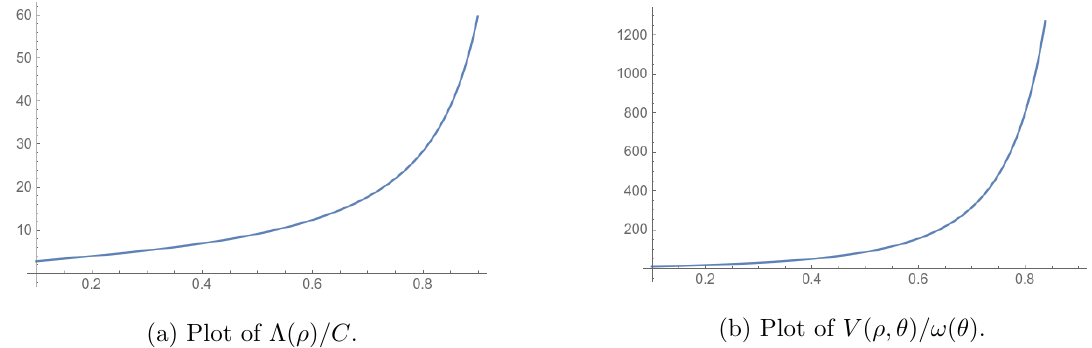
(a) Plot of (cid:3)( (cid:26) ) =C . Figure 12. Plot of the radial pro(cid:12)les of (cid:3) =C and V for the hyperbolic punctured